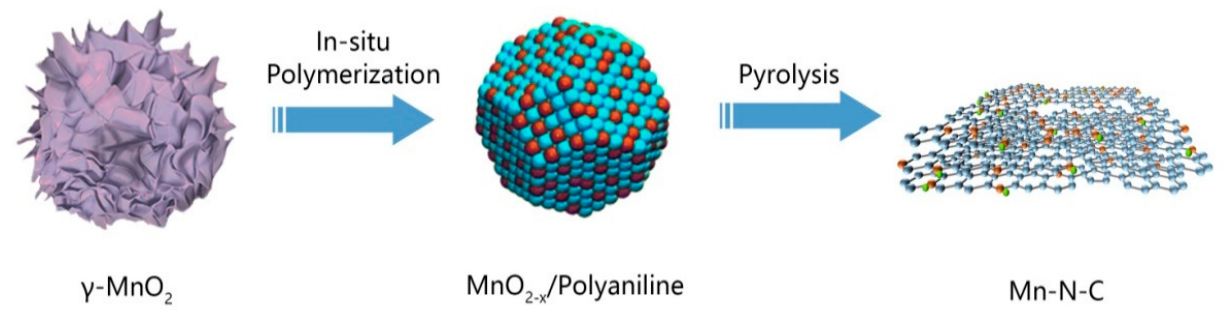
Figure 1. Synthetic route of Mn-N-C nanostructure.